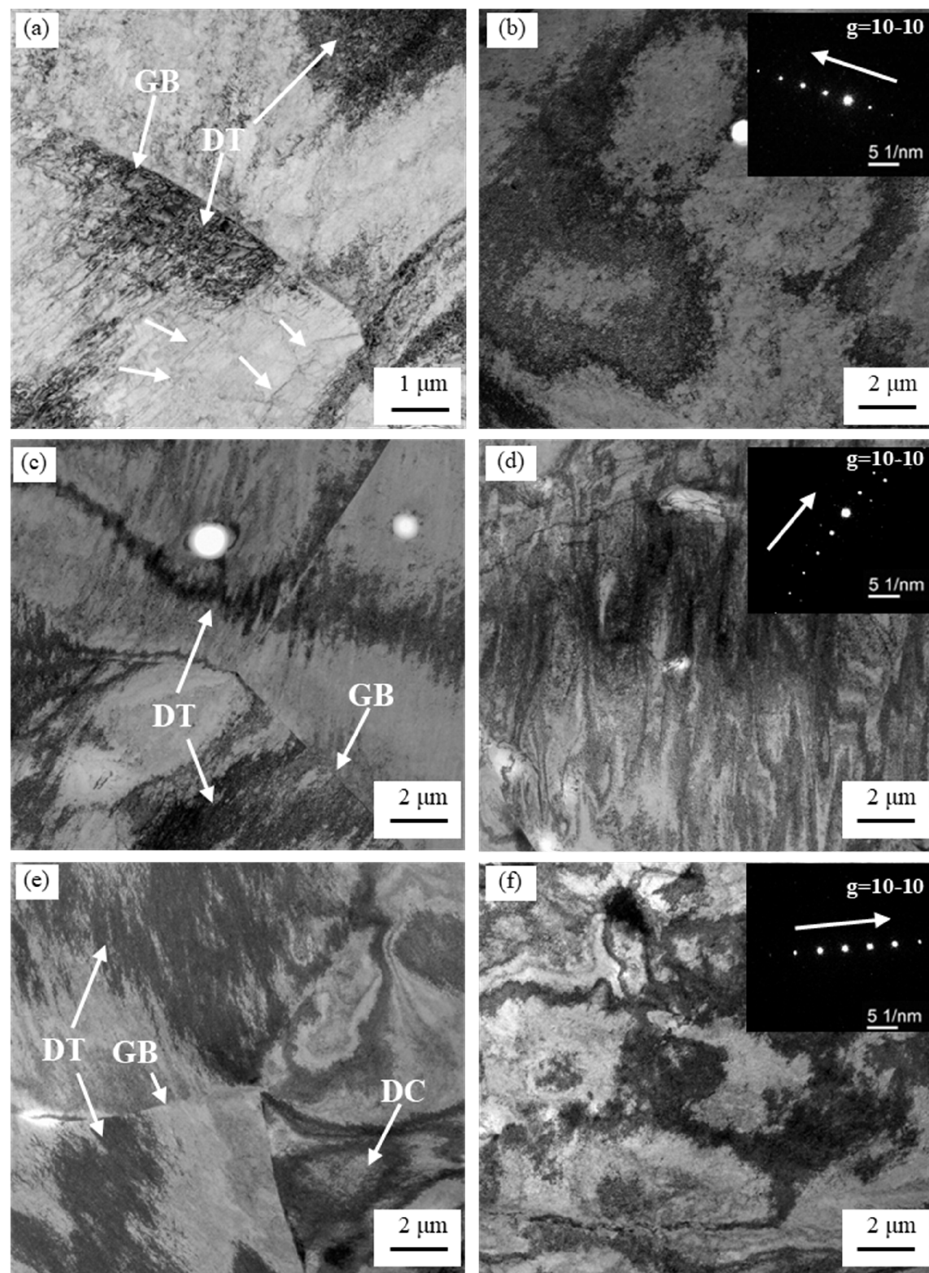
Figure 4. TEM BF images of ( a , c , e ) showing significant increase in the density dislocation with increasing deformation amount and ( b , d , f ) using a g vector of 10–10, in which <a> type dislocation are show in black: ( a ) and ( b ) 15%, ( c ) and ( d ) 25%, ( e ) and ( f ) 42%.